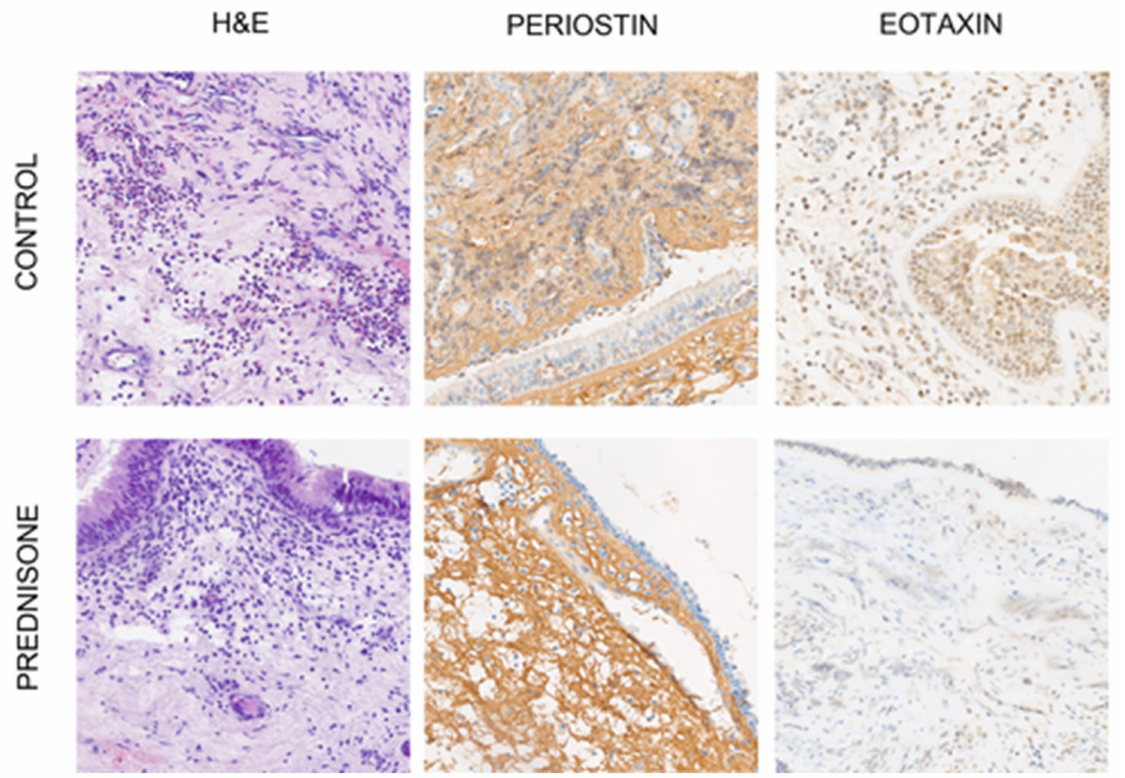
Figure 1. Hematoxylin and eosin staining, periostin and eotaxin expression. Control group compared to group treated with